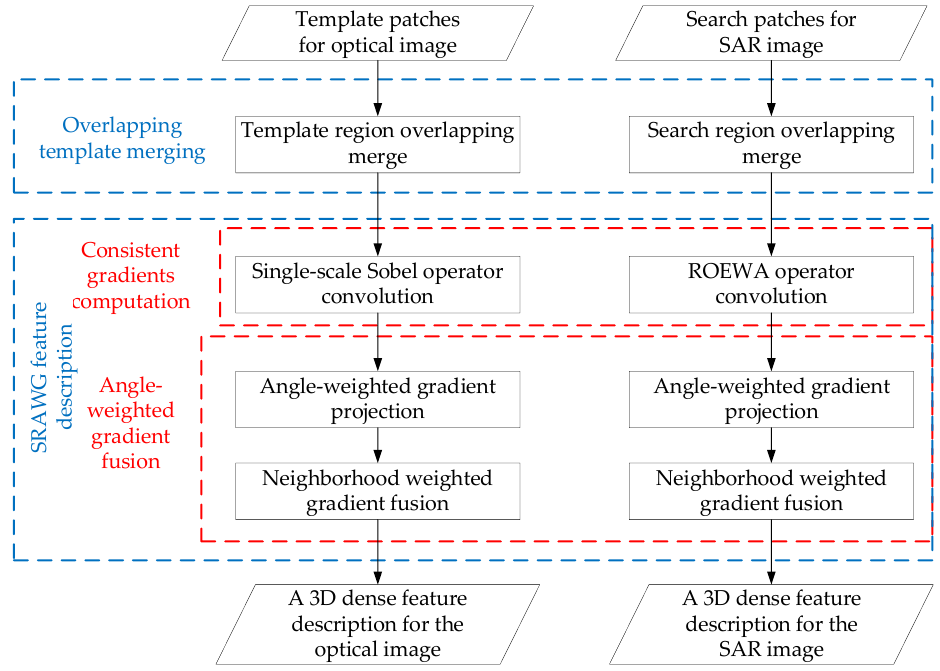
Figure 3. SRAWG feature description construction flow chart.